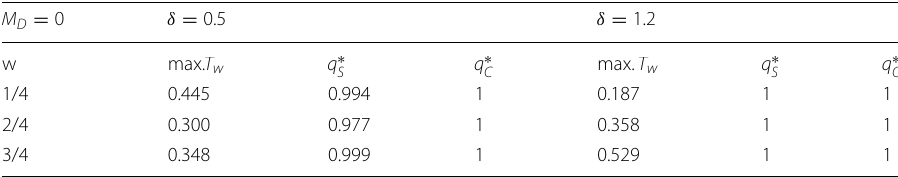
Table 8 The values of q ∗ and q ∗ for which the weighted sum throughput is maximized when the S C queue at S is stable, α = 0.7, M U = 200, M D = 0, and M S = 2000